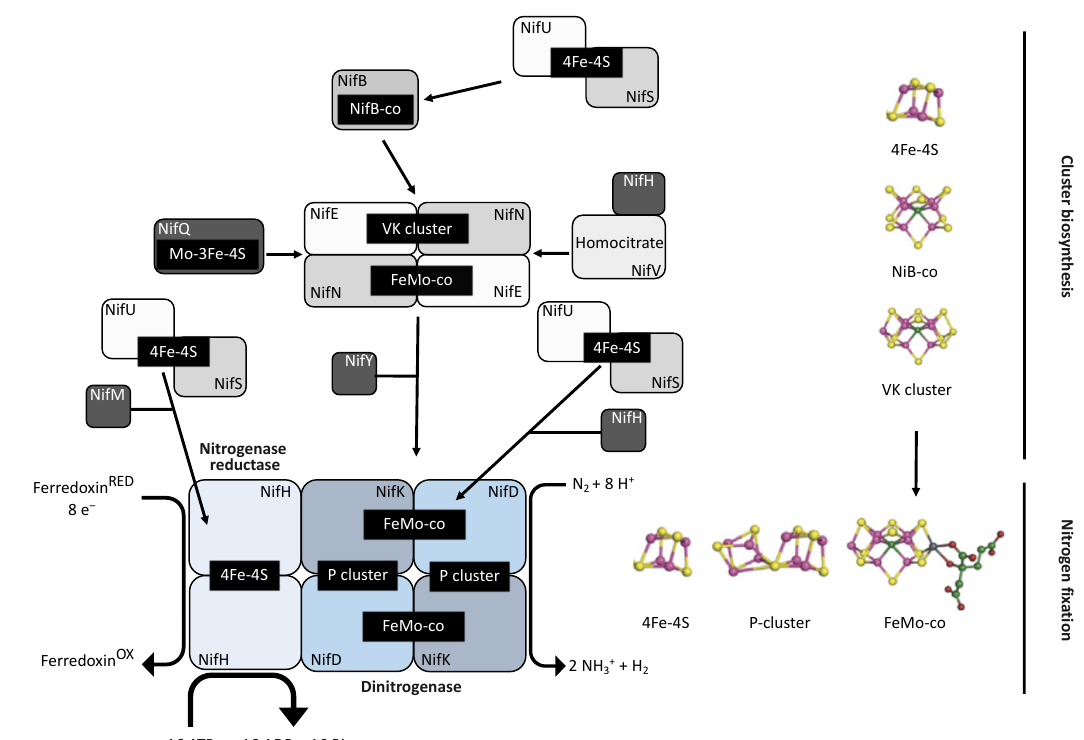
Figure 1. Mo nitrogenase biosynthesis. The enzyme is made of two components, the dinitrogenase reductase (Fe protein) and the dinitrogenase itself (MoFe protein). All the catalytic cofactors contain Fe-S clusters, which are provided by the NifU/NifS system. Sulphur (S) atoms are taken from L-cysteine by the action of NifS. These atoms are assembled into clusters along with Fe ions in the NifU scaffold protein. These Fe-S clusters are then transferred to the apoproteins of the complex. The Fe protein (NifH) acquires these clusters following the action of a maturation factor (NifM). The same system provides the clusters upon which the catalytic cofactors of the dinitrogenase element will be assembled. A functional MoFe protein (NifDK) requires the synthesis and assembly of the P and the FeMo-co. The assemblage of the P cluster relies on the reduction of two 4Fe-4S clusters by NifH into a single 8Fe-7S cluster. On the other hand, the FeMo-co cofactor is assembled outside the NifDK component. In the early steps, 4Fe-4S clusters are transferred to the NifB protein, which is an S-adenosylmethionine (SAM)-dependent enzyme that inserts the C atom into the cluster to form the NifB-co. This newly formed structure is then passed (via NifX or directly) to another scaffold protein made by the products of nifE and nifN . Here, the NifB-co is transformed into a structure known as the VK cluster (8Fe-9S-C). The NifEN protein contains structural 4Fe-4S clusters, and also a Mo-3Fe-4S cluster. The latter is formed in NifQ, where a molybdenum atom is assembled with an Fe-S cluster provided by the NifU/NifS system, and then transferred to NifEN. Upon interaction between NifH and NifEN, the Mo atom and the homocitrate molecule (provided by NifV) are incorporated into the VK cluster, giving rise to the FeMo-co cofactor, which is then transferred by a chaperone (NifY), or directly, to the apo-NifDK to generate the